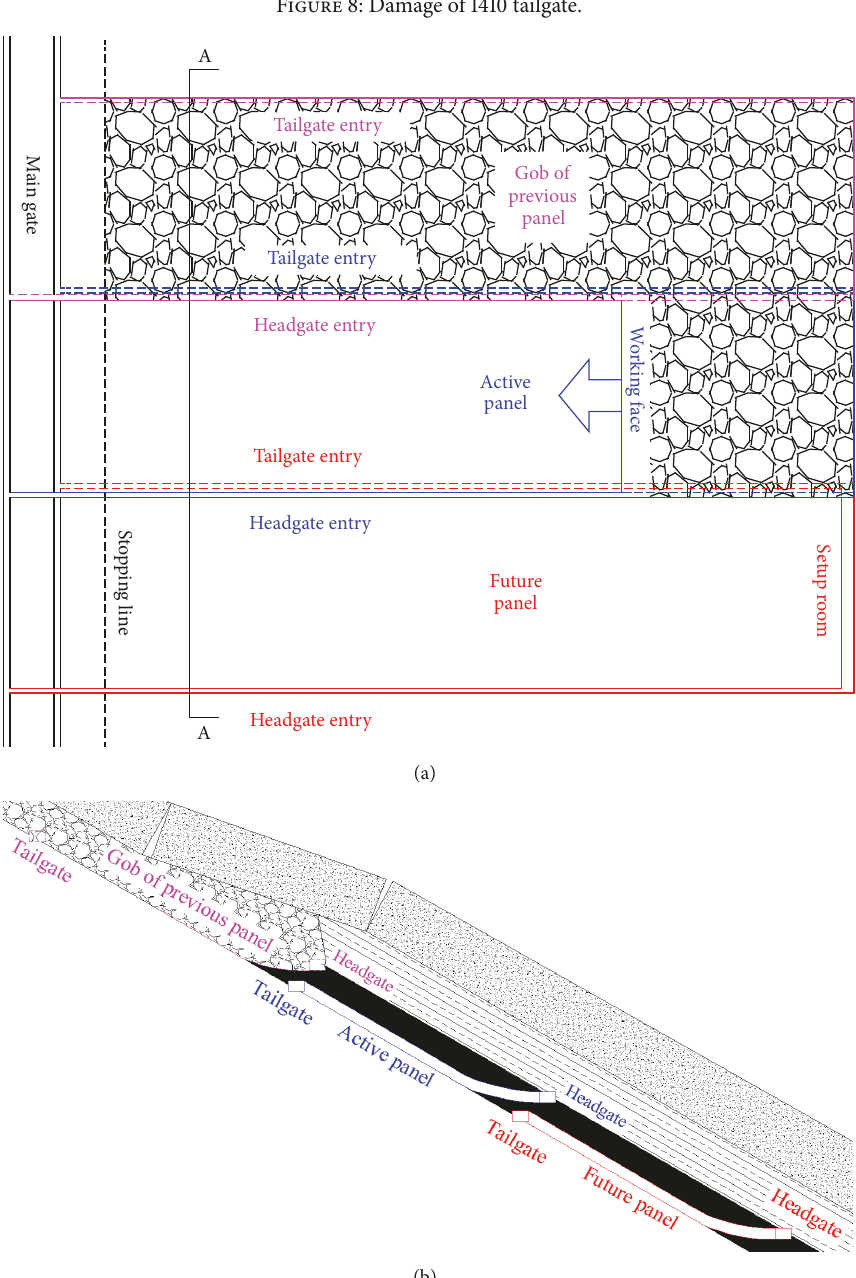
Figure 9: Typical longwall mining with split-level gateroads top coal caving mining layouts (not to scale). (a) Plan view of LMSG panel layout. (b) Section view of LMSG layout in inclined coal